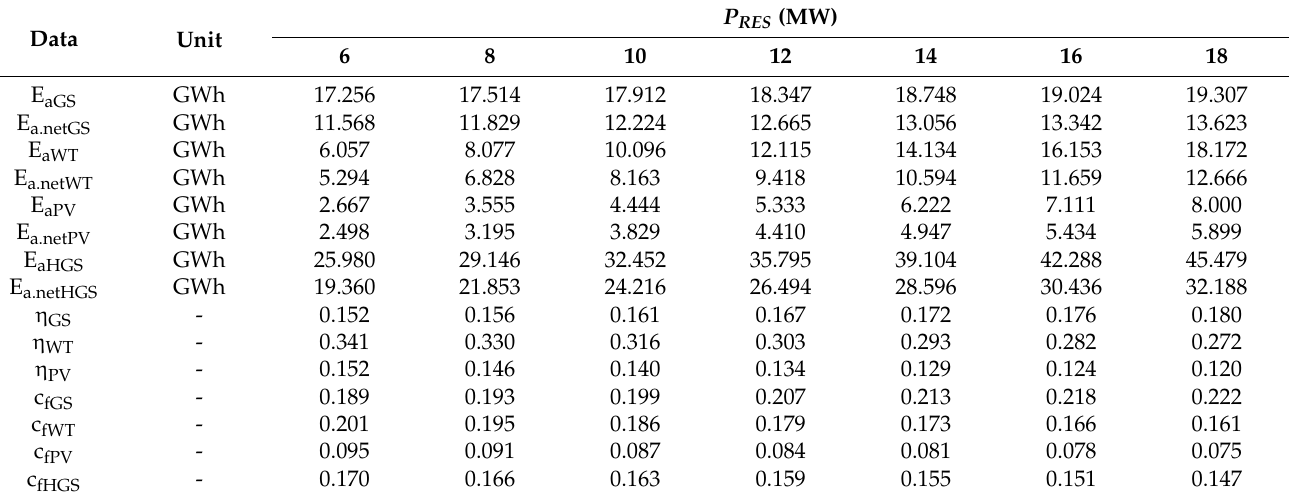
Table 7. Results of energy